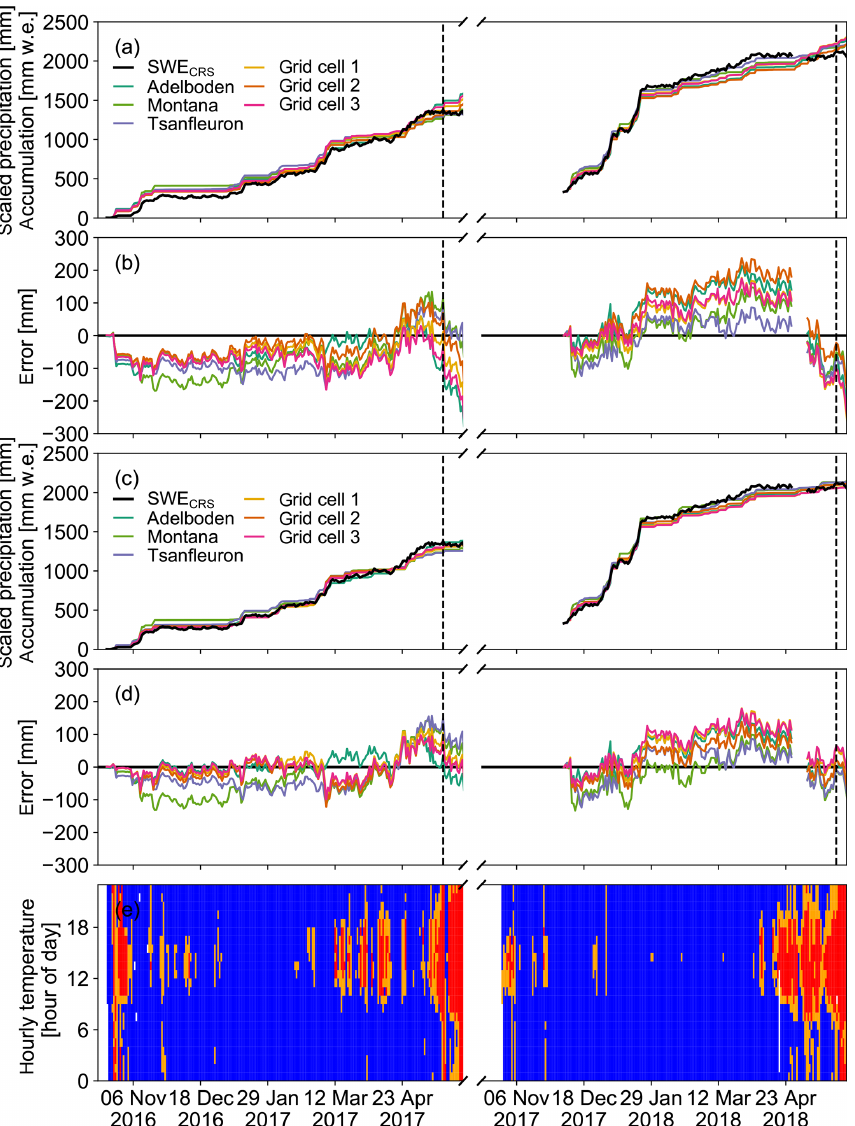
Figure 10. SWE observations (black dots) and scaled cumulative precipitation with (a) one factor and (c) three precipitation-phase-dependent scaling factors (see Table 7). Panels (b, d) show the difference between precipitation and SWE of (a, c) , respectively. The hourly temperature at Plaine Morte is visualized in (e) with temperatures above 3 ◦ C colored in red, between 0 and 3 ◦ C in orange, and below 0 ◦ C in blue. The dashed line corresponds to the date of the seasonal maximum in